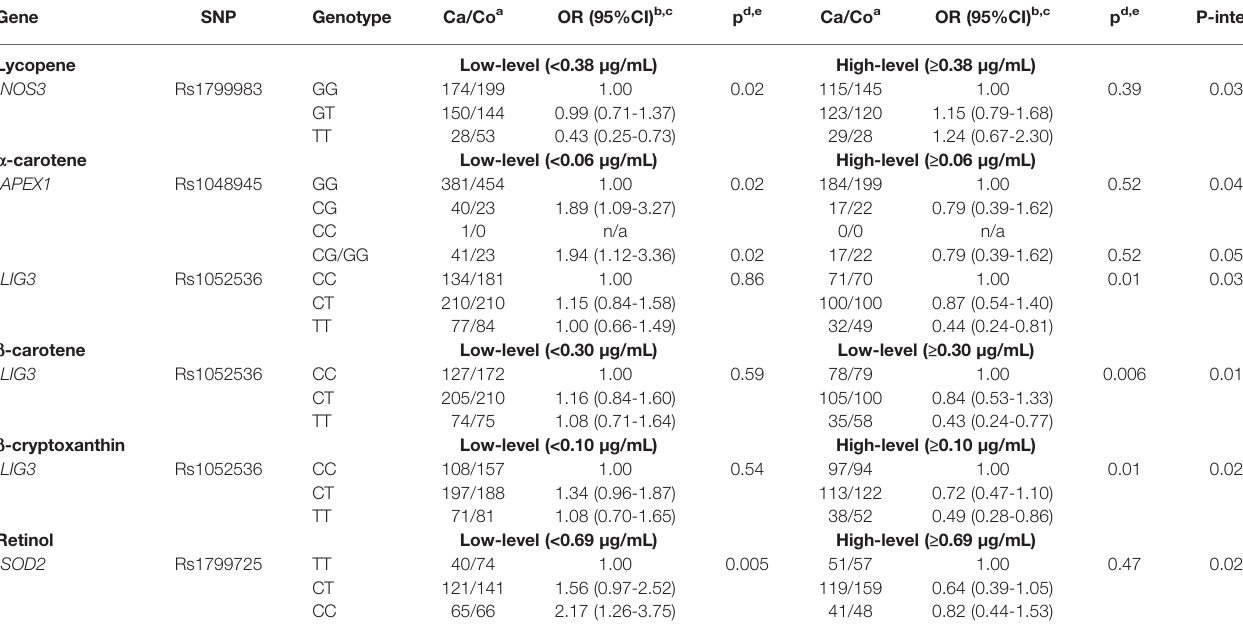
TABLE 4 | Associations of SNPs with prostate cancer risk strati fi ed by serum antioxidants in PCPT fi nasteride arm. Gene SNP Genotype Ca/Co a OR (95%CI)